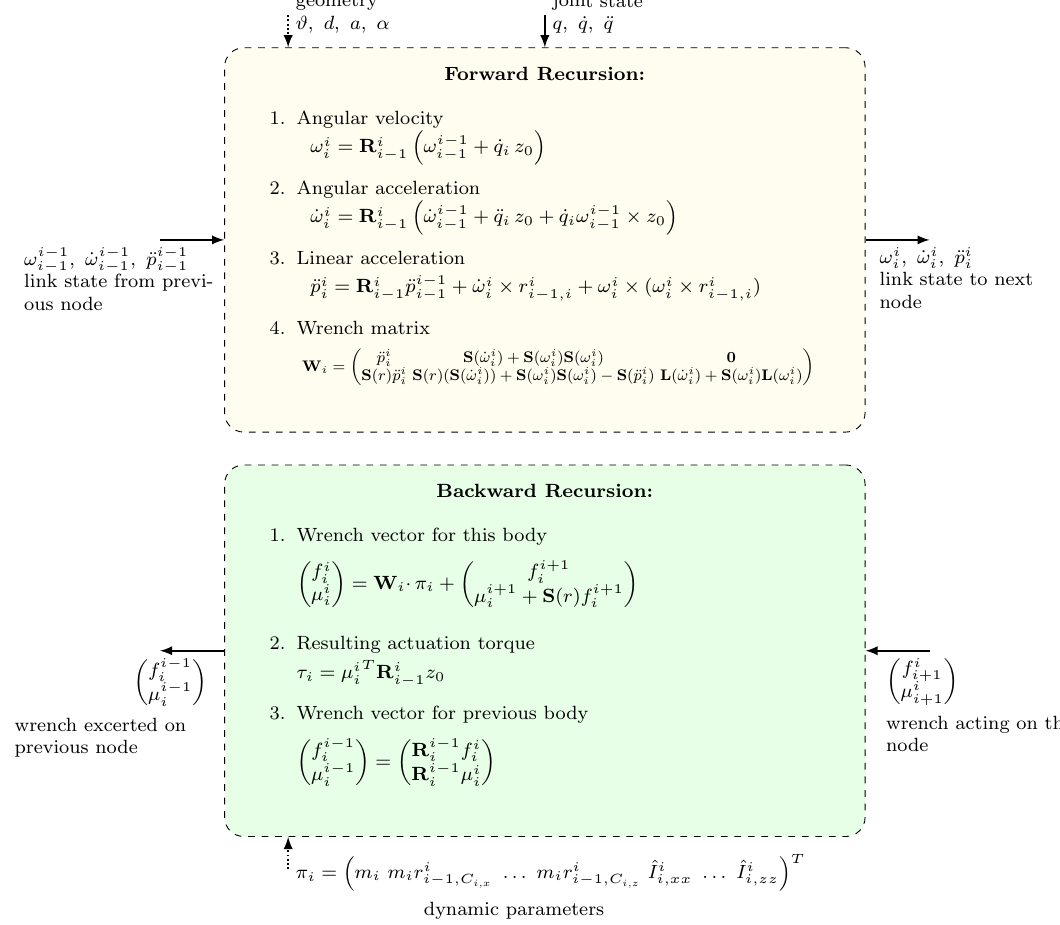
joint state q, ˙ q, ¨ q